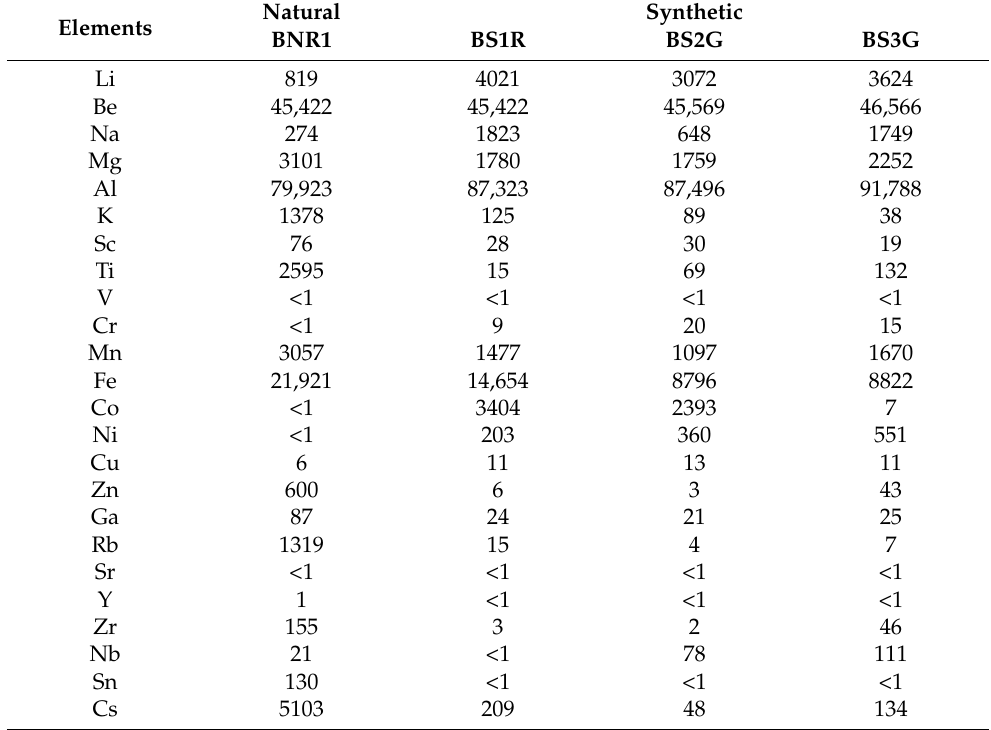
Table 2. Chemical composition (in wt ppm) of the synthetic and natural red beryls based on LA-ICP- MS